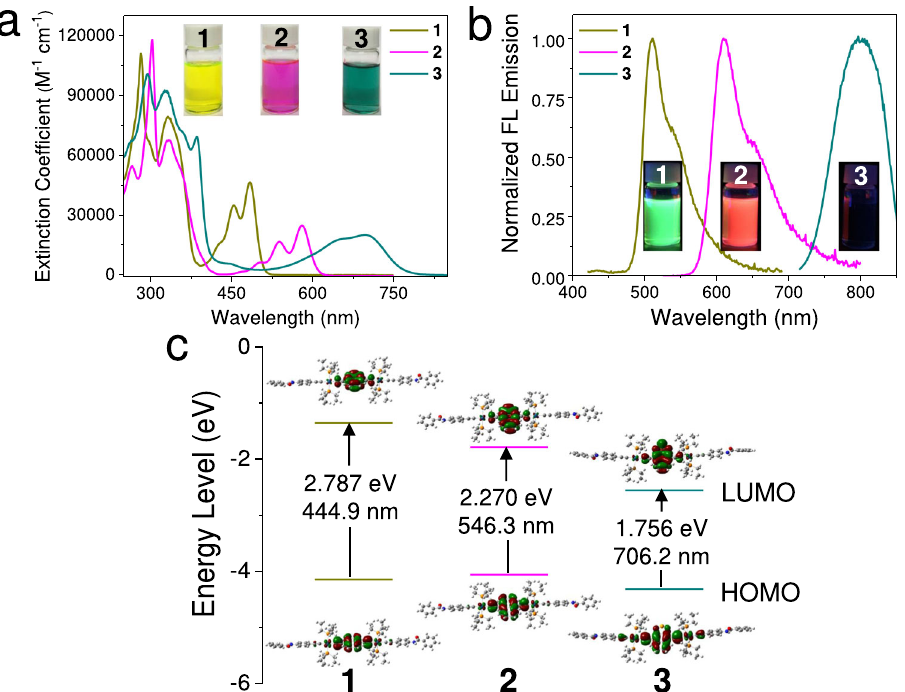
Fig. 2 Spectroscopic characterizations of the designed compounds 1 – 3. a , b Absorption and emission spectra of 1 – 3 ( c : 1.0 × 10 − 5 mol L – 1 for 1 – 2 in dichloromethane and for 3 in 1,2-dichloroethane), together with the corresponding photographs taken under the same concentration and solvent conditions. The inset photographs in Fig. 2b were taken under a hand-held ultraviolet lamp with an excitation wavelength of 365 nm. c Energy level diagram of 1 – 3 based on DFT computations. HOMO and LUMO represent the highest occupied molecular orbital and the lowest unoccupied molecular orbital,